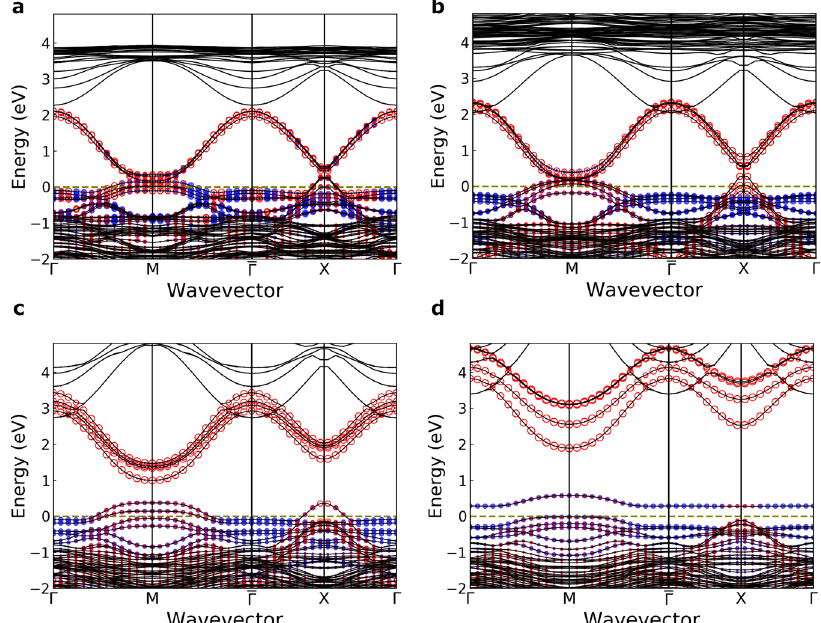
Fig. 7 Band structures for HSE06 functional with different mixing parameter values. Band structure comparison by varying mixing parameter in the HSE06 hybrid functional for a a = 0, b a = 0.05, c a = 0.15, and d a = 0.25 in doped LTO phase. The blue- fi lled and red empty circles correspond to copper d z 2 and copper d x 2 (cid:3) y 2 orbitals, respectively. The projection strength is denoted by marker